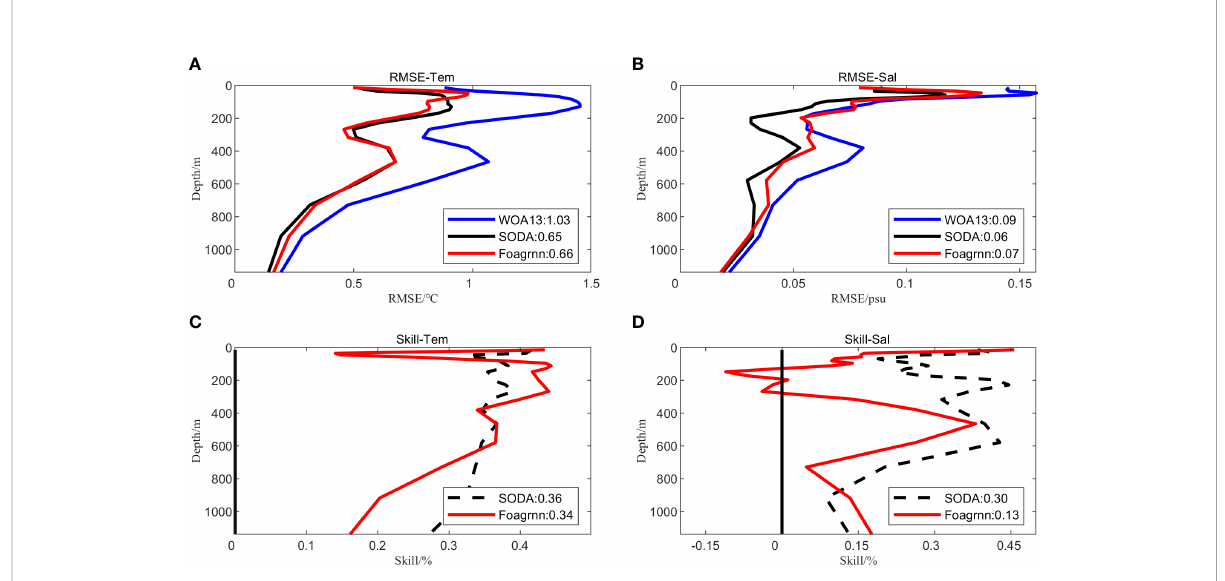
FIGURE 3 Temperature (left) and salinity (right) pro fi les root mean square errors (RMSEs) and skill scores as a function of depth. (A) temperature pro fi les RMSE, (B) salinity pro fi les RMSE, (C) skill score of temperature pro fi les relative to WOA13, (D) skill score of salinity pro fi les relative to WOA13. The black line represents SODA3.4.2 reanalysis data; the red line represents the synthetic pro fi les; the blue line represents WOA13 climatology data, and the numbers represent the depth mean of RMSE and skill